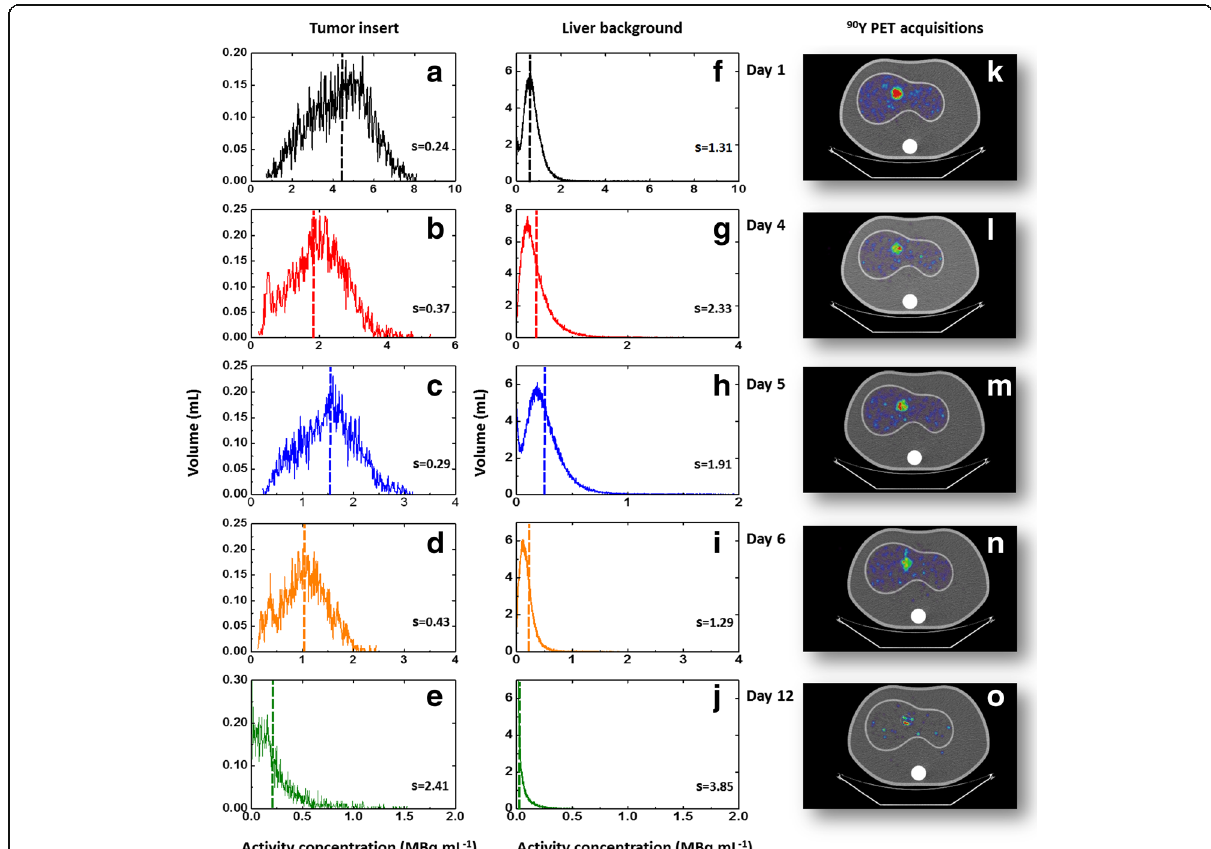
Fig. 2 Differential activity concentration volume histograms (dAVH). 90 Y – PET images were reconstructed using a GE Discovery ST PET/CT system with 2.73 × 2.73 × 3.27mm 3 detector elements. A full 3D-OSEM VUEPoint HD reconstruction algorithm, two iterations, 15 substeps, was used. Acquisitions